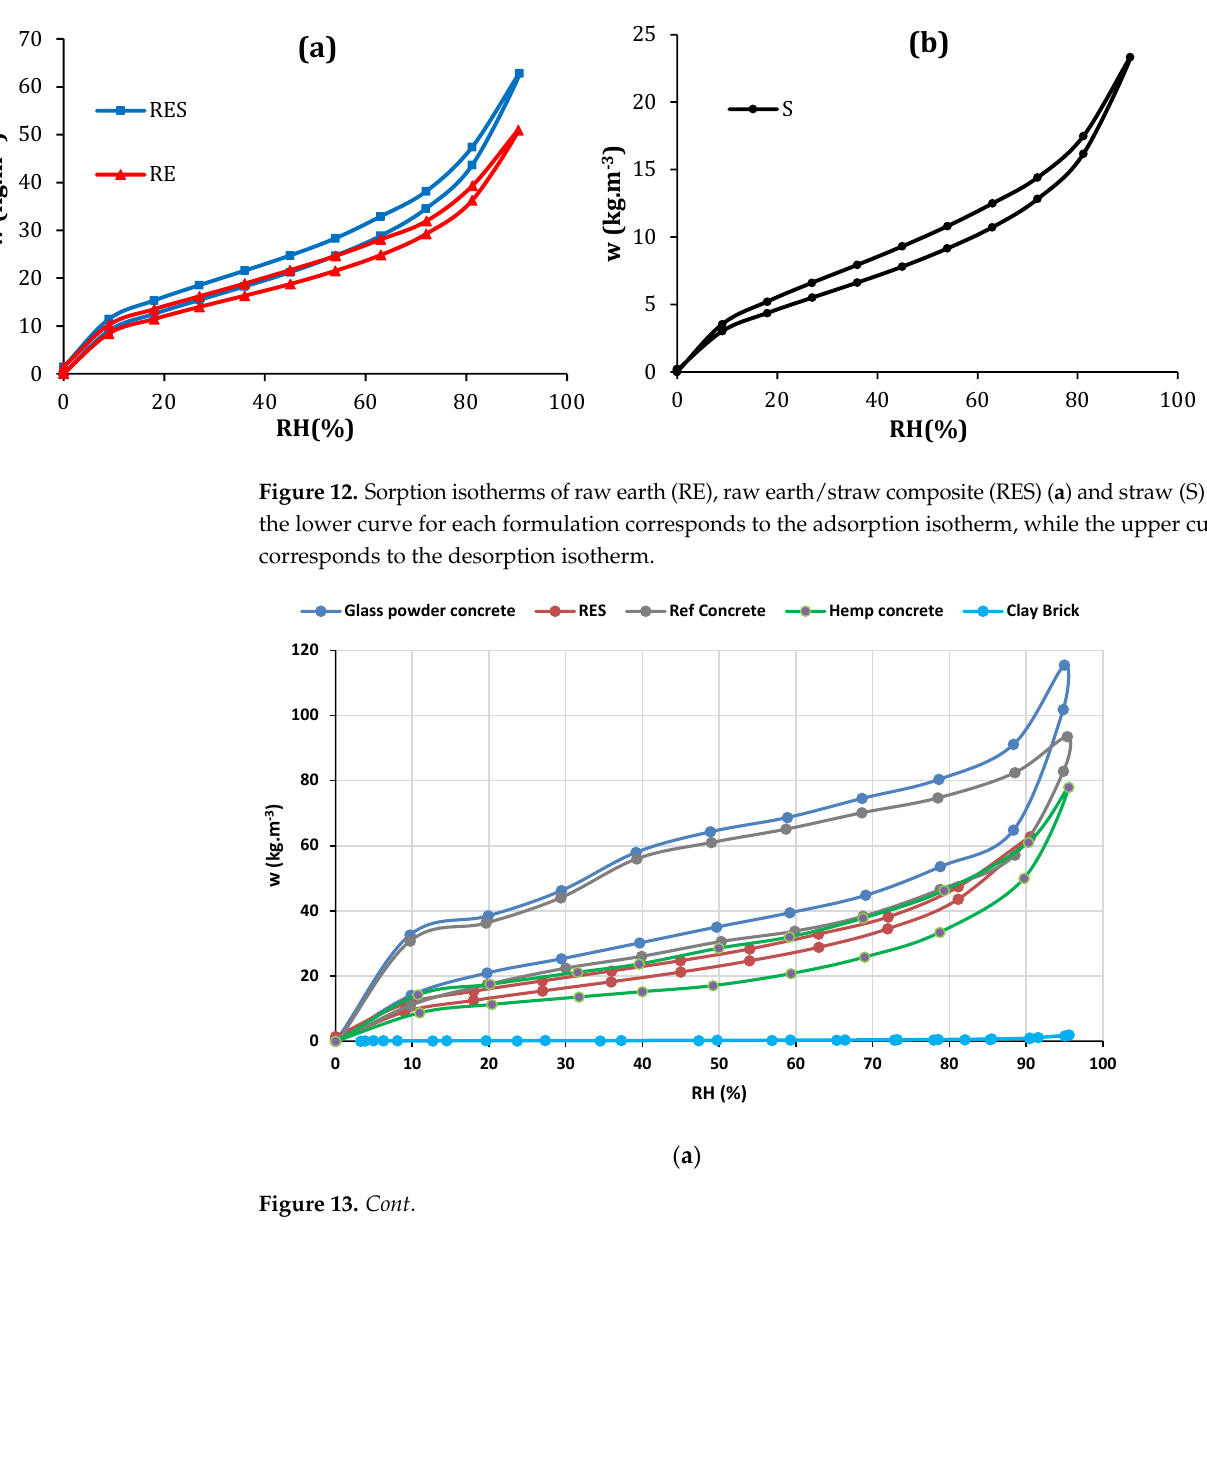
( b ) Figure 13. Comparison of sorption isotherms of concrete, glass powder concrete, hemp concrete, clay brick, and raw earth/straw (RES) in terms of water content ( a ) and mass ratio ( b ).